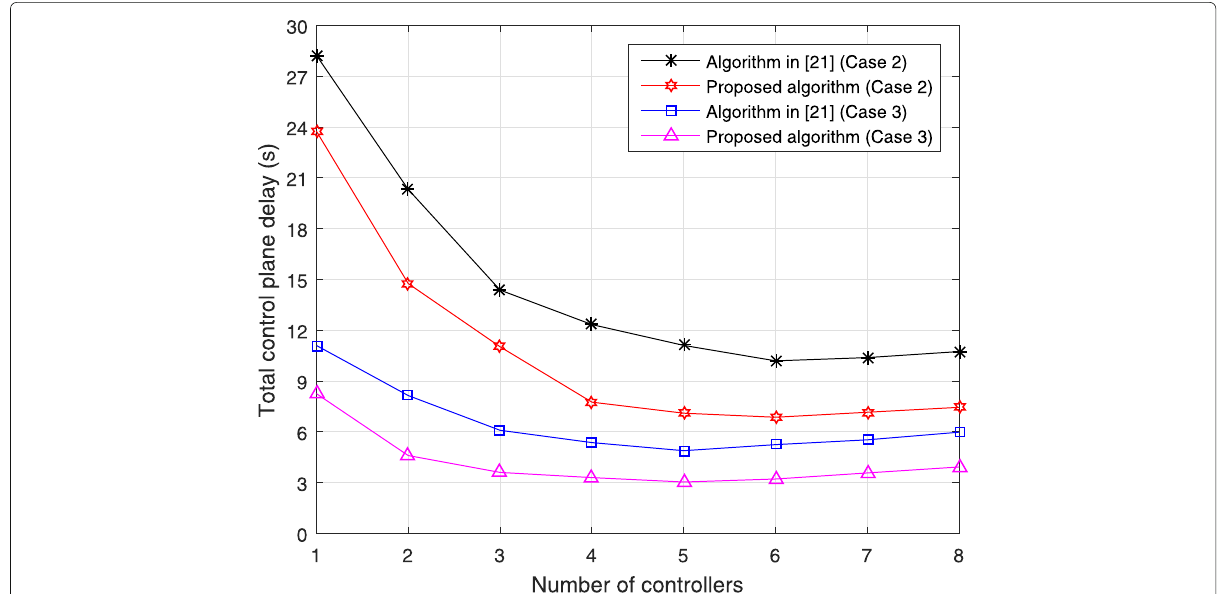
Fig. 4 Control plane delay versus the number of controllers (different cases). The control plane delay versus the number of controllers for different